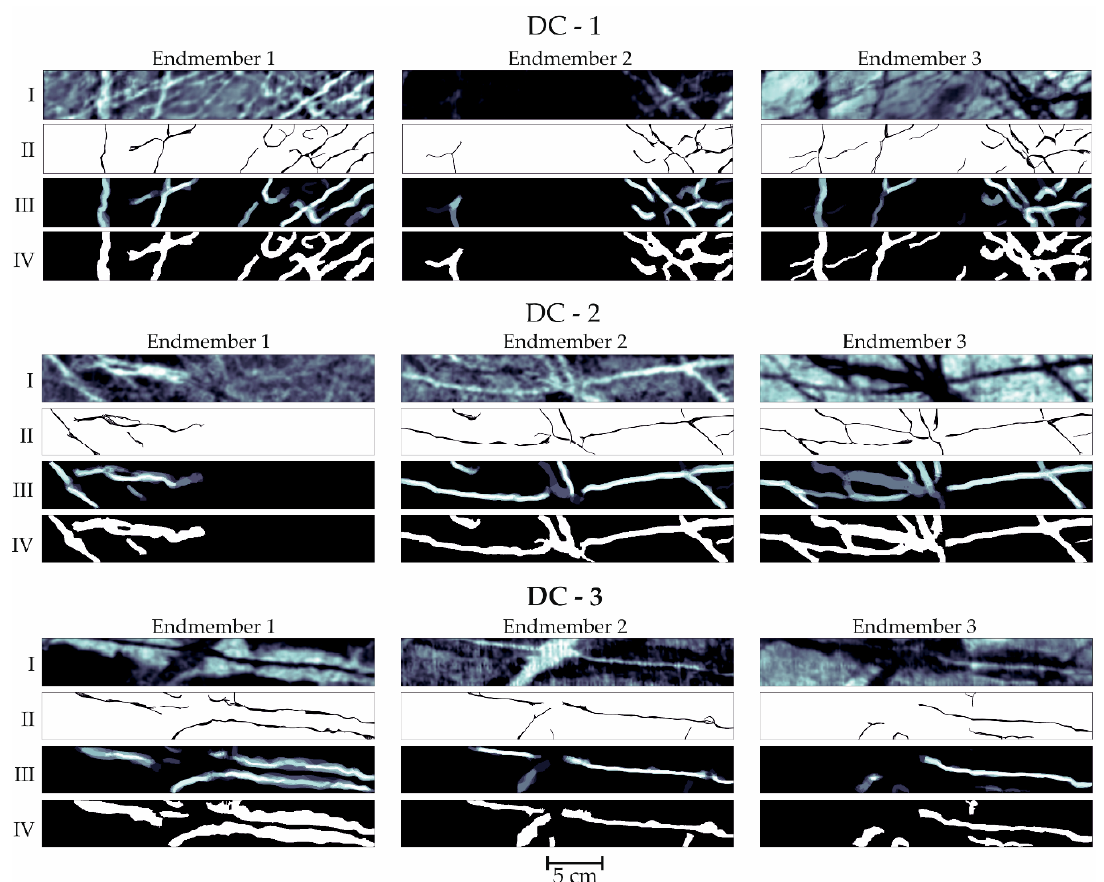
Figure 8. Results of the vein extraction performed on the endmember abundance maps obtained by FC-LSU. I = endmember abundance map, II = extracted ridges for sigma ranging from 3 to 10 and thresholds ranging from 98% to 92%, III = overlapping polygons after connecting extracted lines to their respective edges (features detected with wider range of sigma are brighter), IV = extracted veins after merging all polygons.